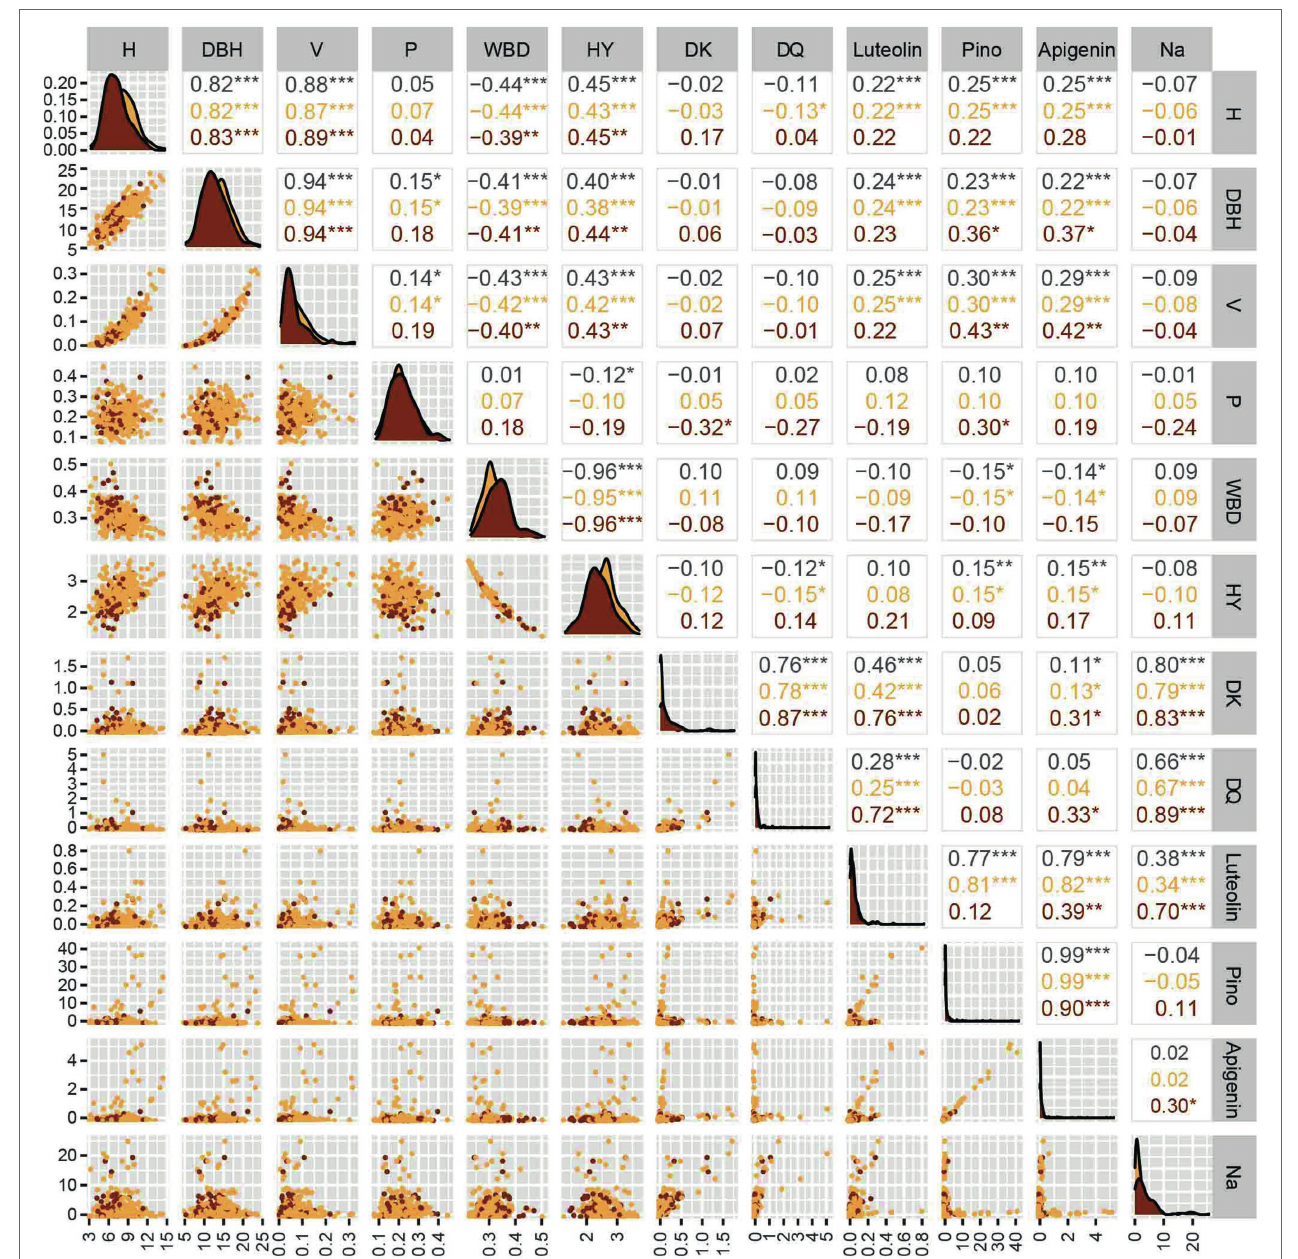
FIGURE 2 | Phenotypic differences and correlations of six growth-related traits and the contents of six secondary metabolites in red-heart and white-heart Chinese fir. H, tree height; DBH, diameter at breast height; V, volume; P, percentage of heartwood; WBD, wood basic density; HY, water absorption; DK, dihydrokaempferol; DQ, dihydroquercetin; Pino: pinocembrin; and Na,